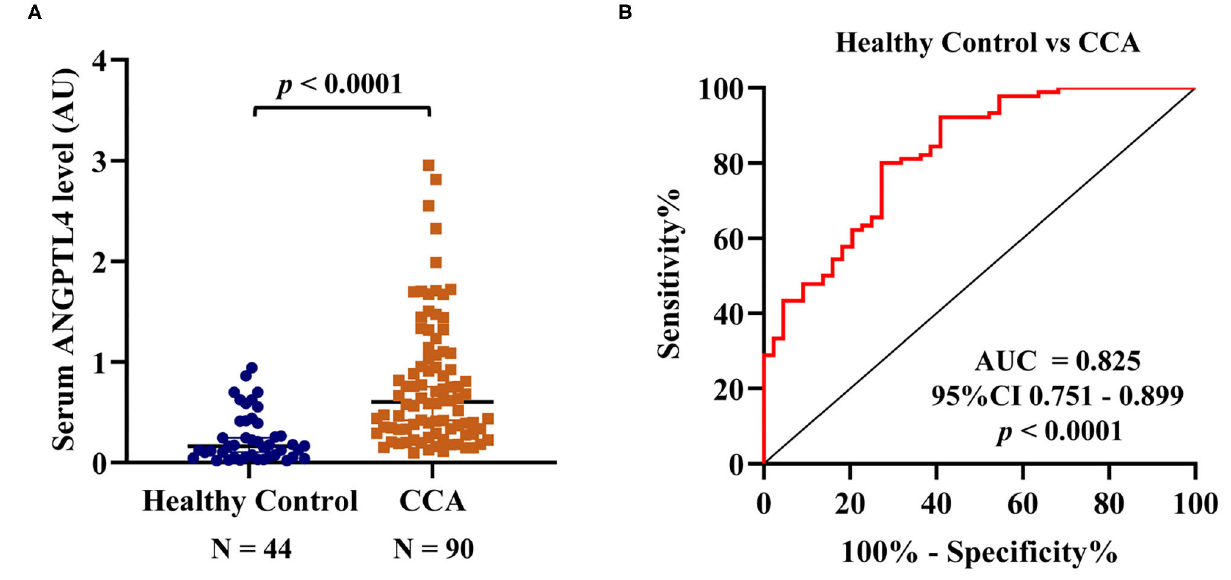
Frontiers in Public Health |